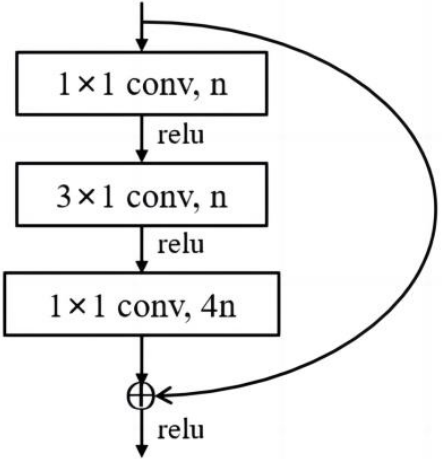
Figure 2. Bottleneck Structure.